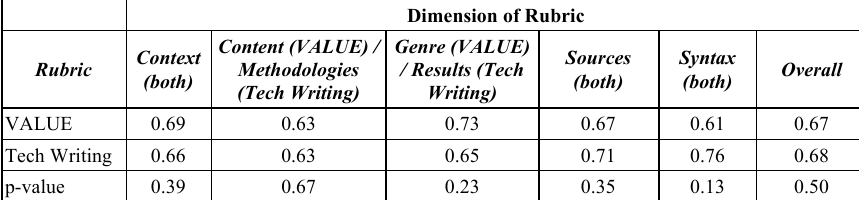
Table 2. Normalized Mean Scores for VALUE and Technical Writing